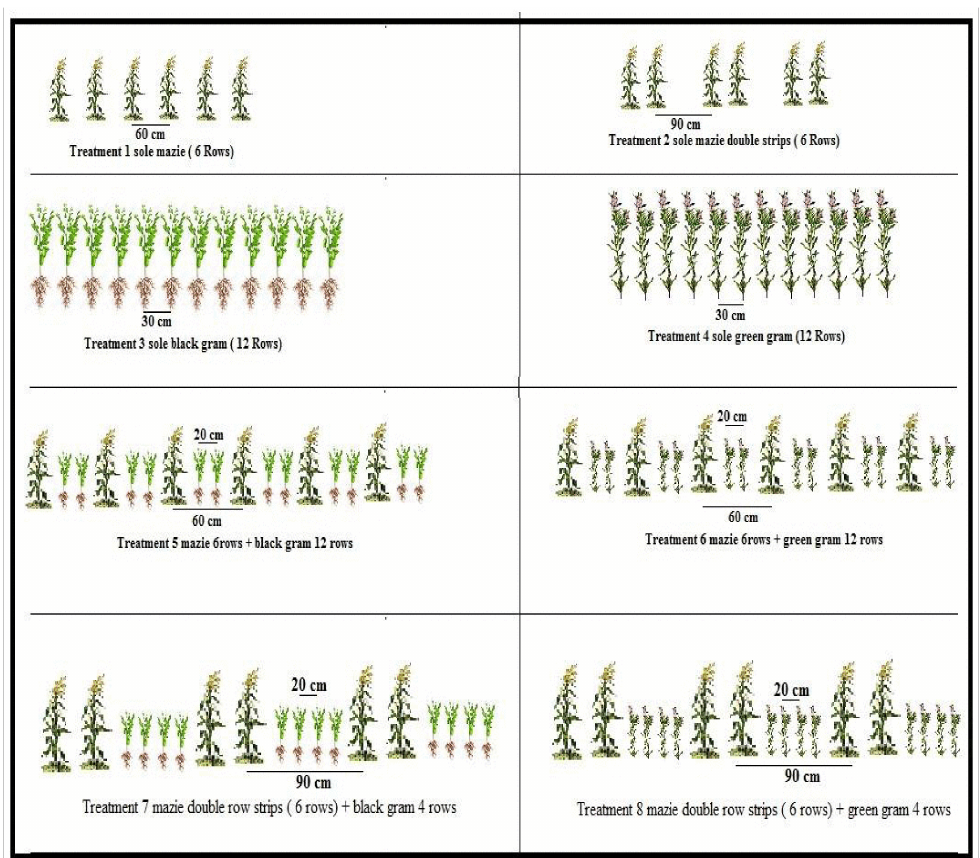
Figure 1. Schematic sketch of row placement of black and green grams in maize at various planting patterns in the